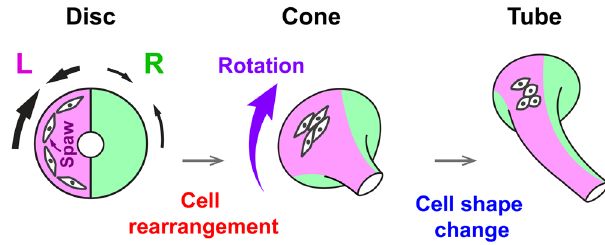
Fig. 9 Diagram summarizing the process of heart tube formation in zebra fi sh. The disc-to-tube transformation occurs through convergent extension, initially driven by oriented cell rearrangement and subsequently by cell shape change. Both cell behaviors occur circumferentially toward the anterior seam of the left (L) and right (R) primordia (black arrows), converging the disc anteriorly along the circumferential direction. Nodal (Spaw) signaling promotes rearrangement and shape changes of left cells, leading to more rapid convergence of the left primordium, and thereby rotating the disc